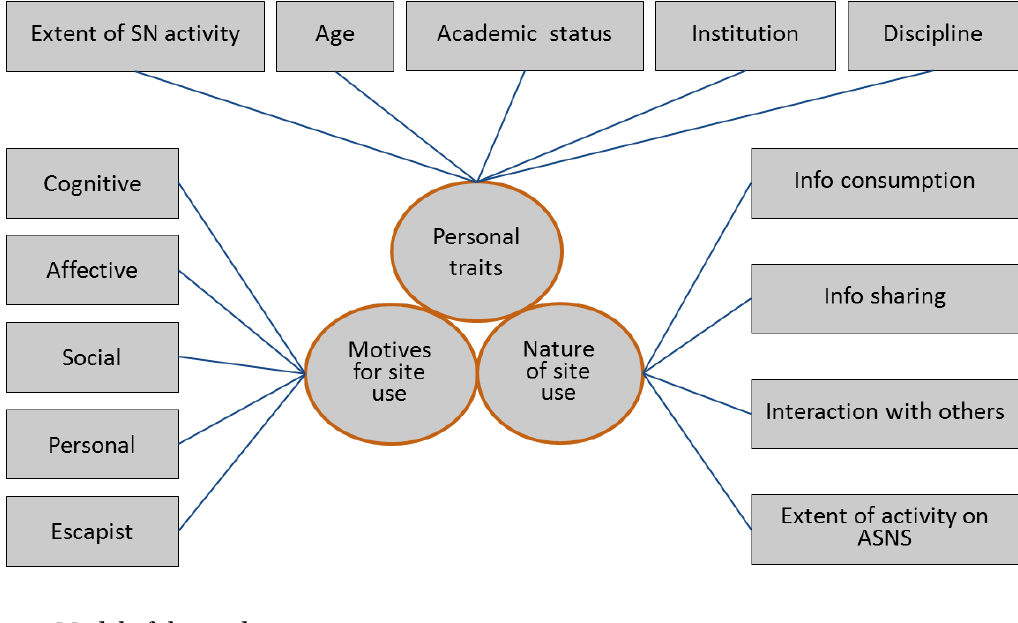
Figure 1. Model of the study.